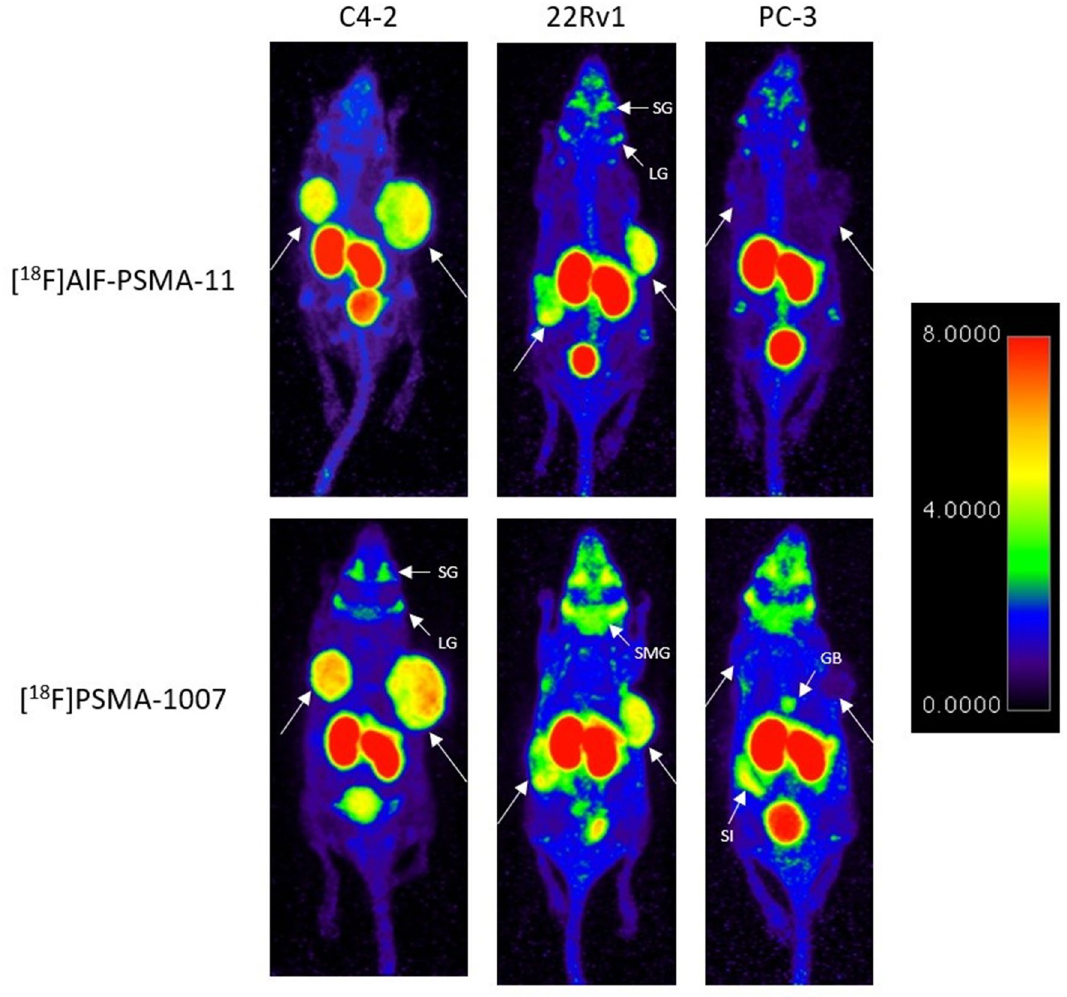
Figure 2. Representative images of mice with either C4-2 (high PSMA expression), 22Rv1 (medium PSMA expression) and PC-3 (no PSMA expression) xenografts. All mice underwent PET/CT imaging 60 min after the administration of [ 18 F]AlF-PSMA-11 and [ 18 F]PSMA-1007. SG = salivary gland, LG = lacrimal gland, SMG = submandibular gland, GB = gallbladder, SI = small intestines. Color maps were generated using Horos v4.0.0, https:// horos proje ct. org/.